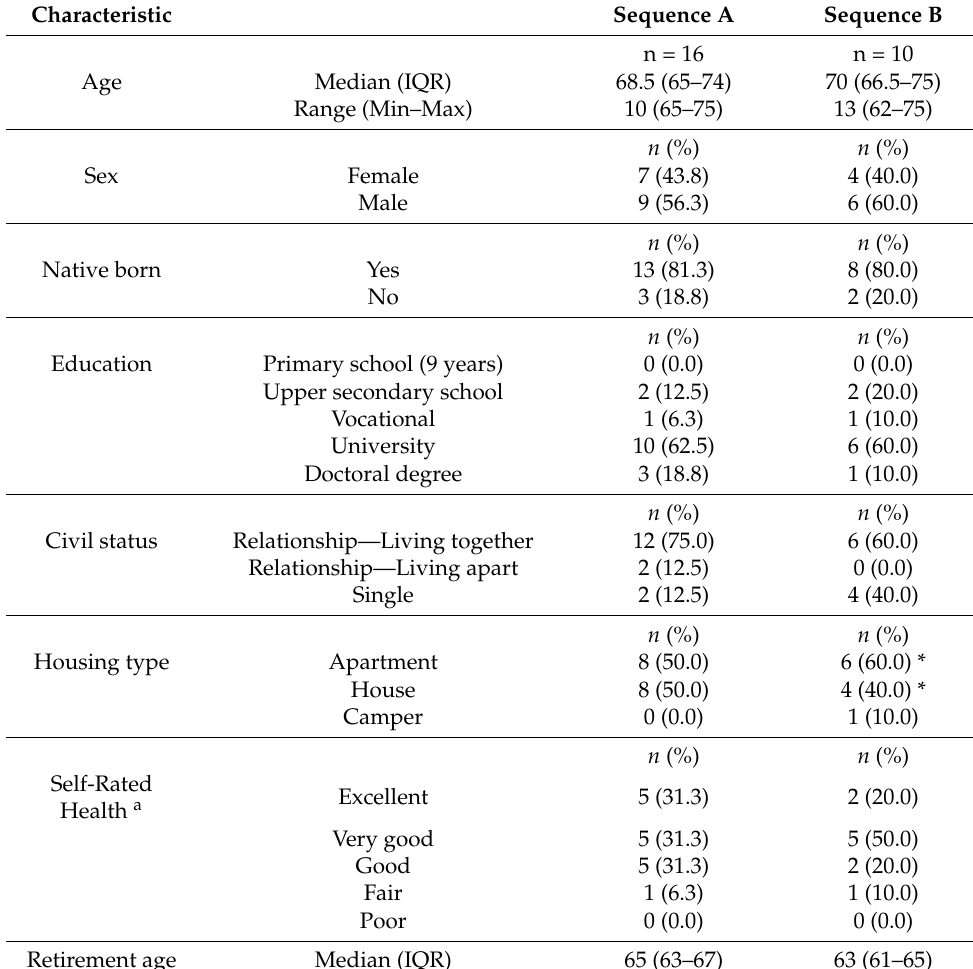
Table 1. Description of the participants (N =